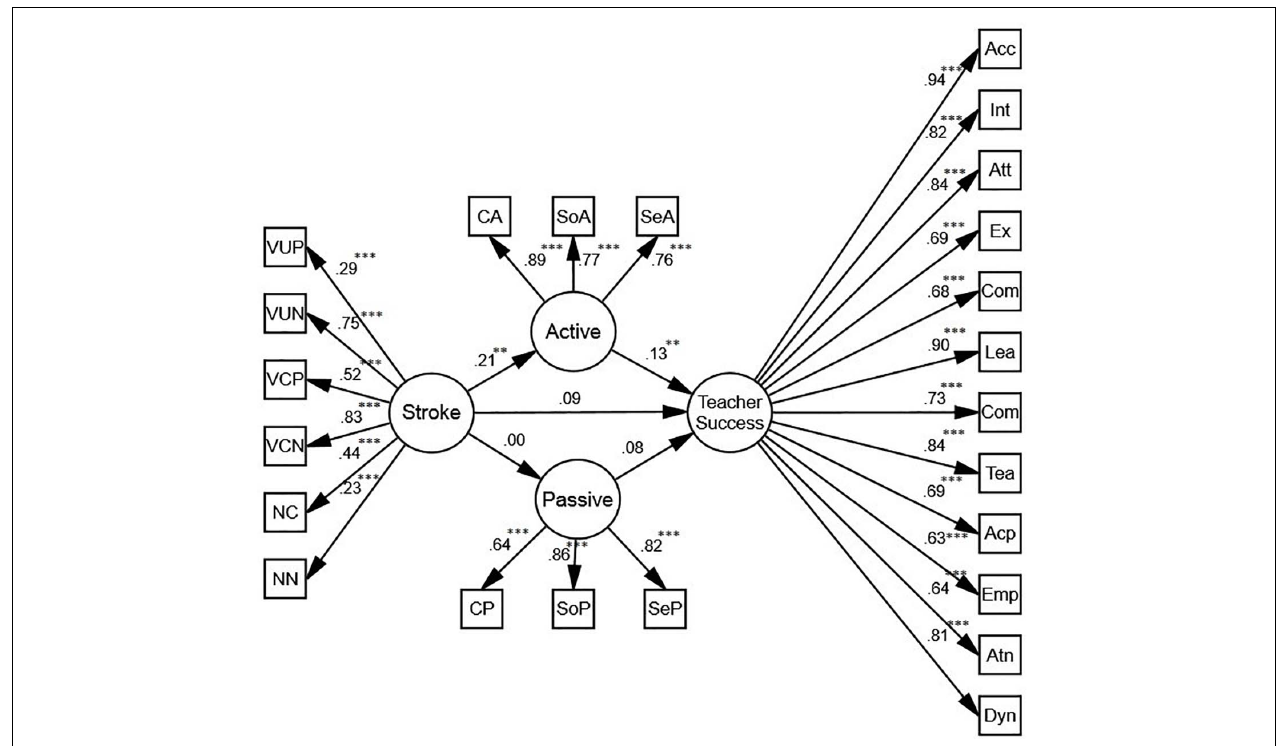
FIGURE 2 | The schematic representation of the relationships among stroke, active and passive motivation, and teacher success (** p < 0.01, *** p < 0.001). In order to see if gender of the participants changes the reported relationships, two more SEM models were proposed.